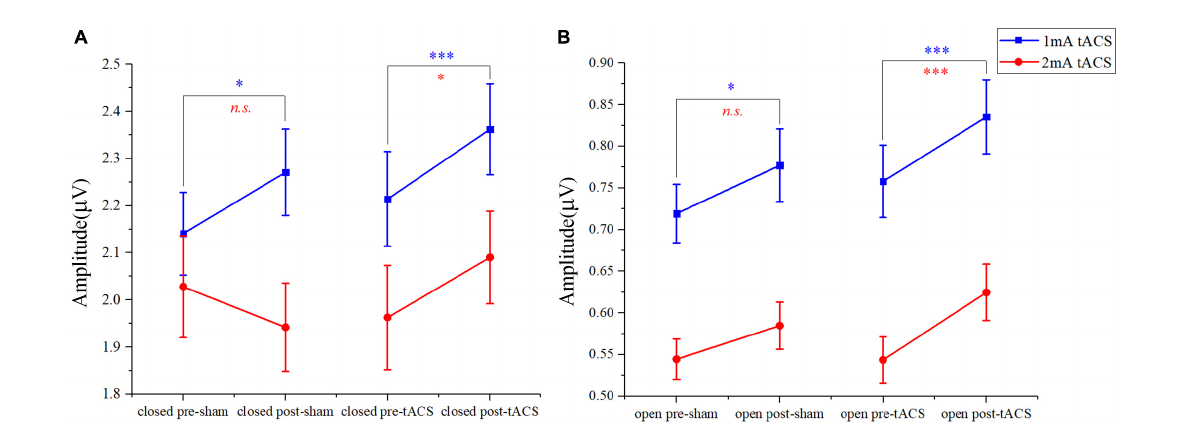
FIGURE5 The paired t -test results in amplitudes between post- and pre-stimulation for different intensities of tACS and sham stimulation. (A) The results of pre-sham, post-sham, pre-tACS, and post-tACS with the eyes-closed condition. (B) The results of pre-sham, post-sham, pre-tACS, and post-tACS with the eyes-open condition; n.s. > 0.05, * p < 0.05, ∗∗∗ p < 0.001.